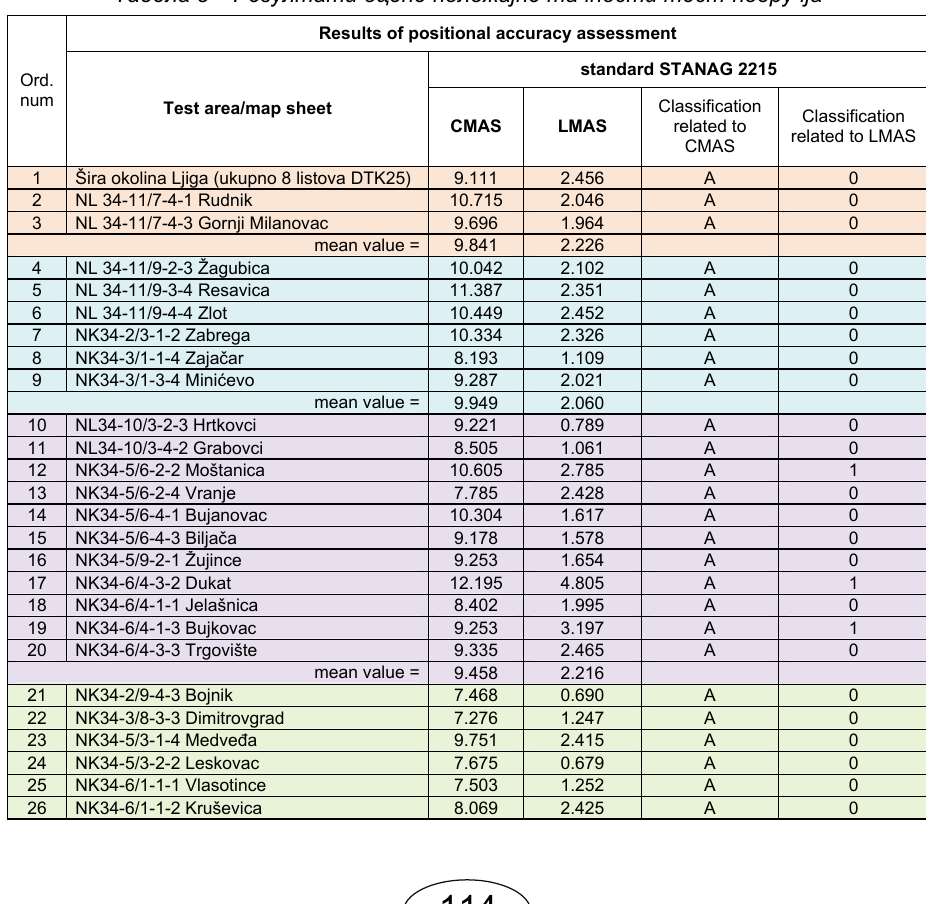
Table 3 – Positional accuracy assessment results of the tested area Таблица 3 – Результаты оценки позиционной точности на тестируемой местности Табела 3 – Резултати оцене положајне тачности тест - подручја Results of positional accuracy assessment standard STANAG 2215